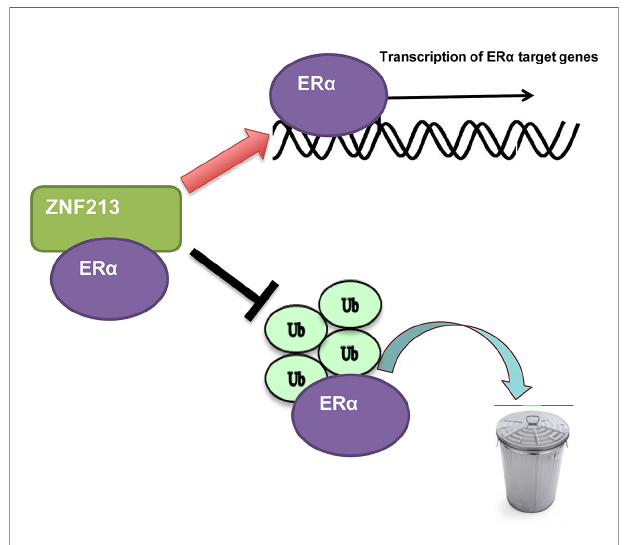
FIGURE 6 | The hypothetic model of ZNF213 in modulating ER alpha signaling in breast cancer: ZNF213 associates with ER alpha and facilitates ER alpha stability via inhibiting ER alpha poly-ubiquitination and